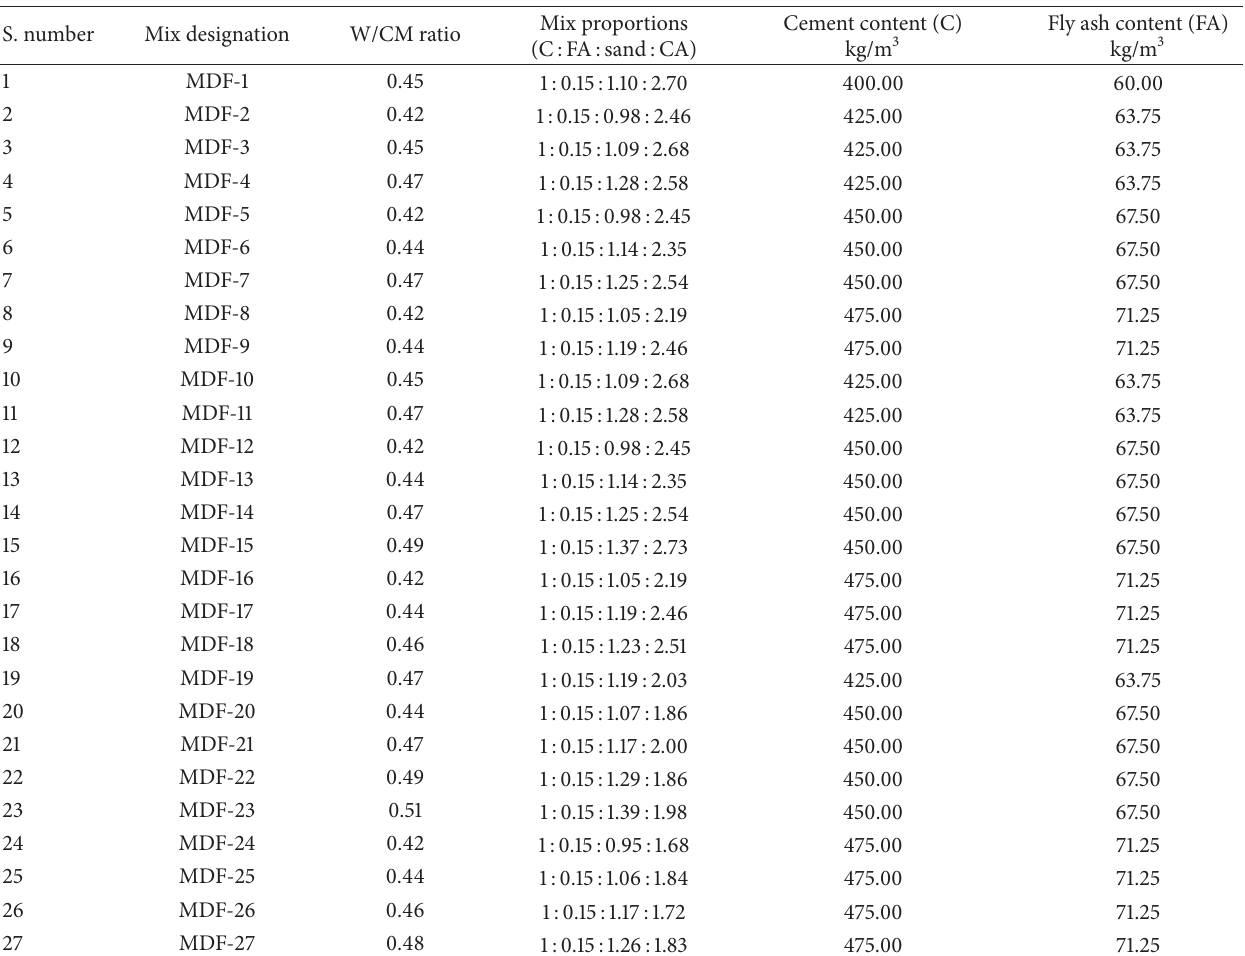
Table 3: Details of proportions for concrete mixes with 0.15 fly ash